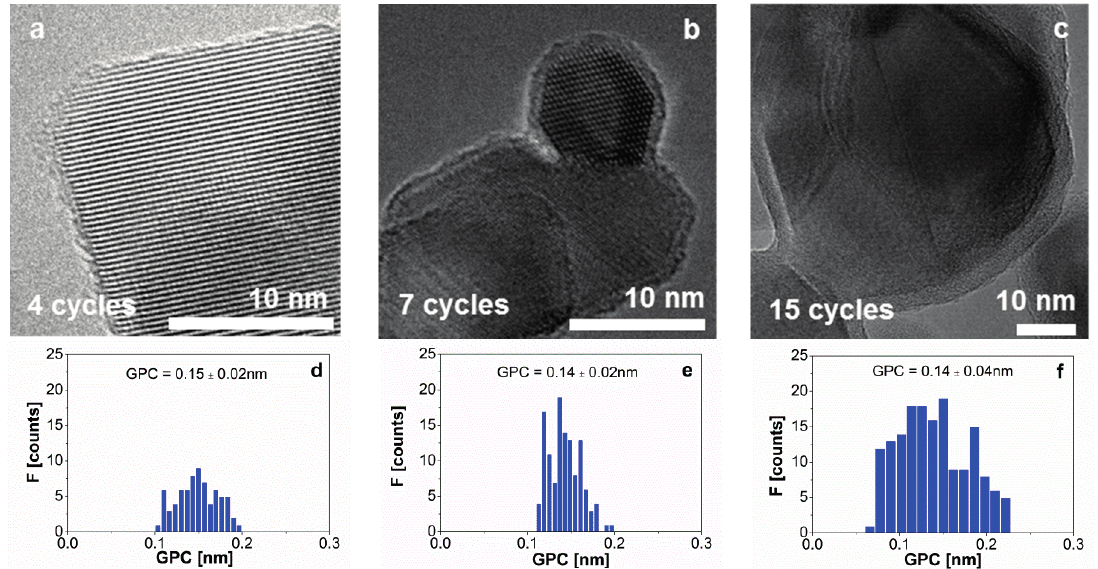
Figure 1. TEM images of the alumina film on TiO 2 nanoparticles for a dosing sequence of 3.5–10–2.5–10 min after ( a ) 4 ALD cycles; ( b ) 7 ALD cycles; and ( c ) 15 ALD cycles. ( d ) Distribution of the growth per cycle from the TEM pictures after 4 ALD cycles; ( e ) after 7 ALD cycles; and ( f ) after 15 ALD cycles. The mean growth per cycle and the standard deviation values are given in each histogram.